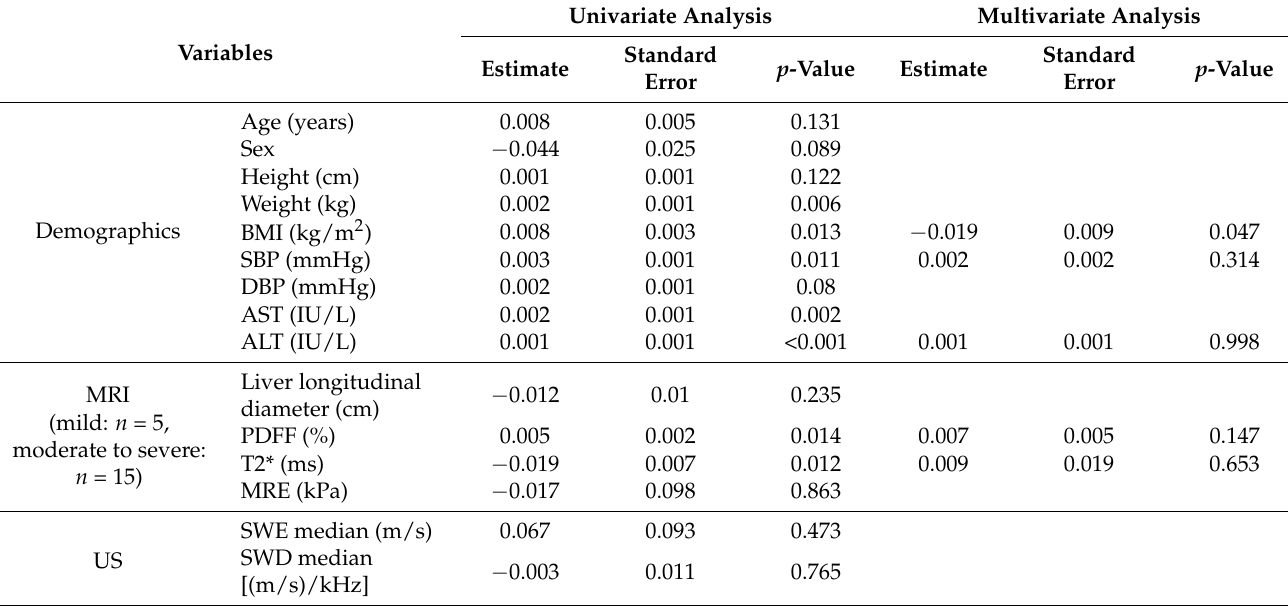
Table 3. Results of the linear regression analysis for ATI median values in all groups.